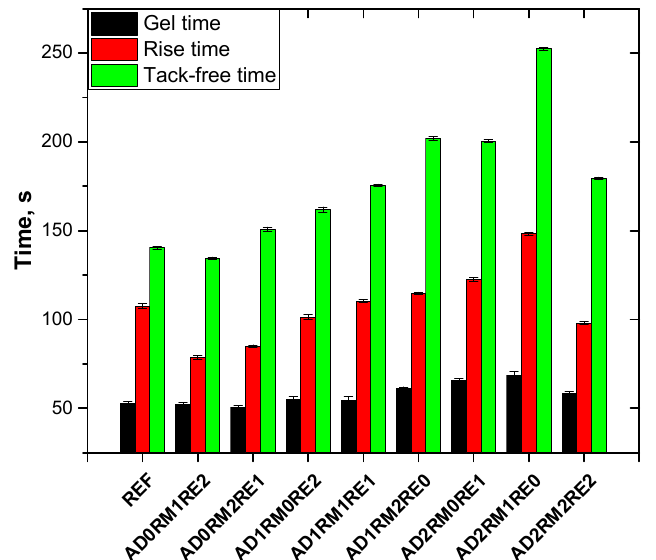
Figure 2. Characteristic processing times of the tested polyurethane foam compositions.